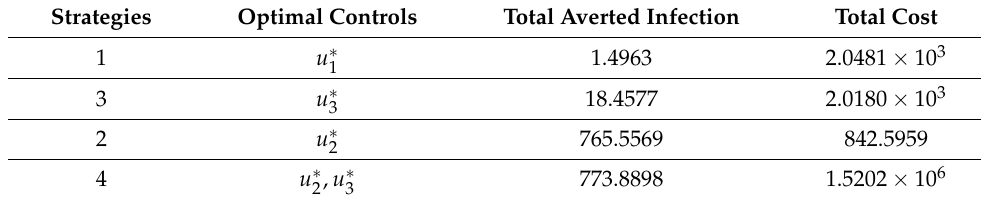
Table 2. Numerical value of total averted infections and cost of each strategy. Strategies Optimal Controls Total Averted